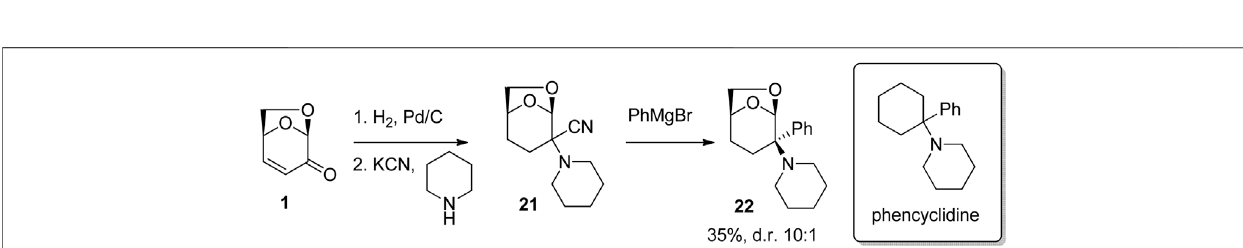
FIGURE 6 | 1,4-Additions of vinyl cuprates to LGO for the preparation of thromboxane analogues.